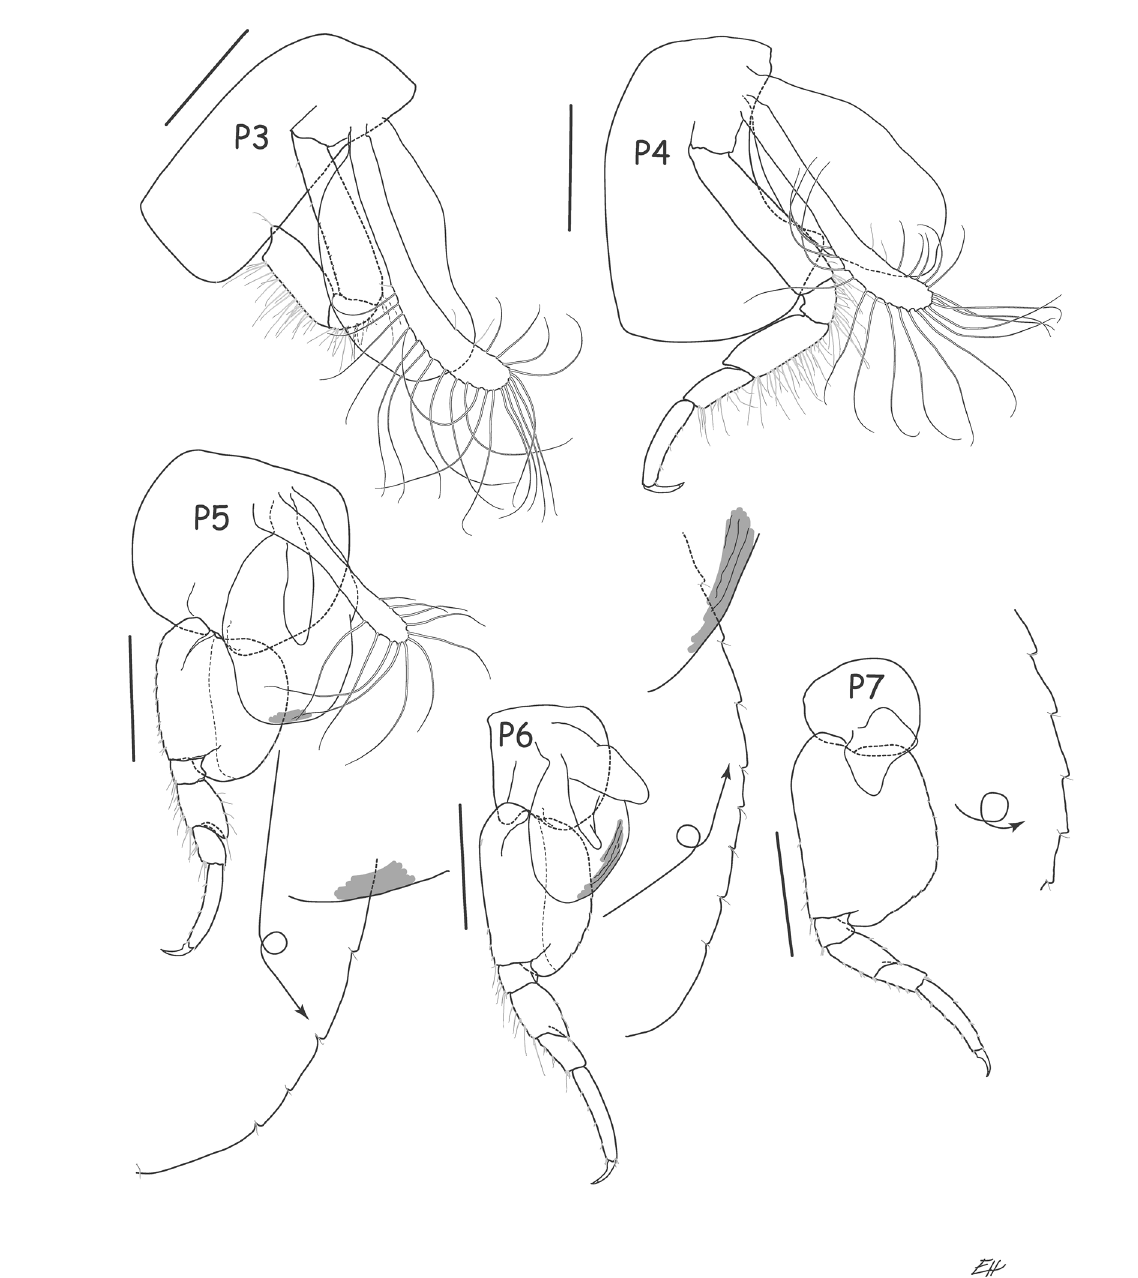
mm.palp article 2 strongly widened at distal two-thirds, with 10 (left side) or 9 (right side) contiguous conical apical spines, and one apical strong seta on outer corner. m axilla 2 ( Fig . 13). Outer and inner plates tapering distally, both with strong rows of pectinate medial marginal spines and setae; inner plate much shorter and distinctly narrower than outer plate, with marginal setae on the distal third of the inner margin, distal end of inner plate not reaching the proximal end of setal row of outer